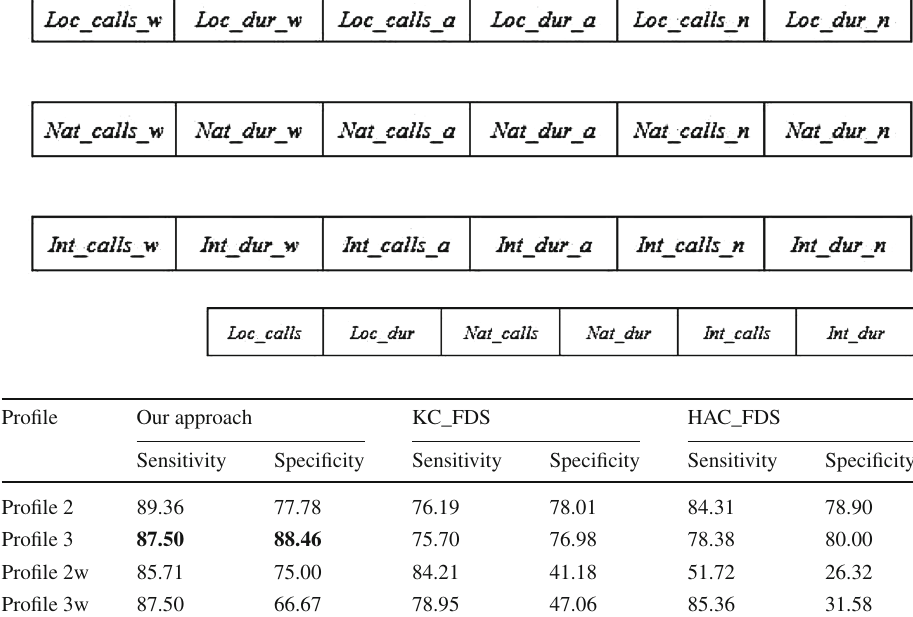
Fig. 5 Profile 2 of user